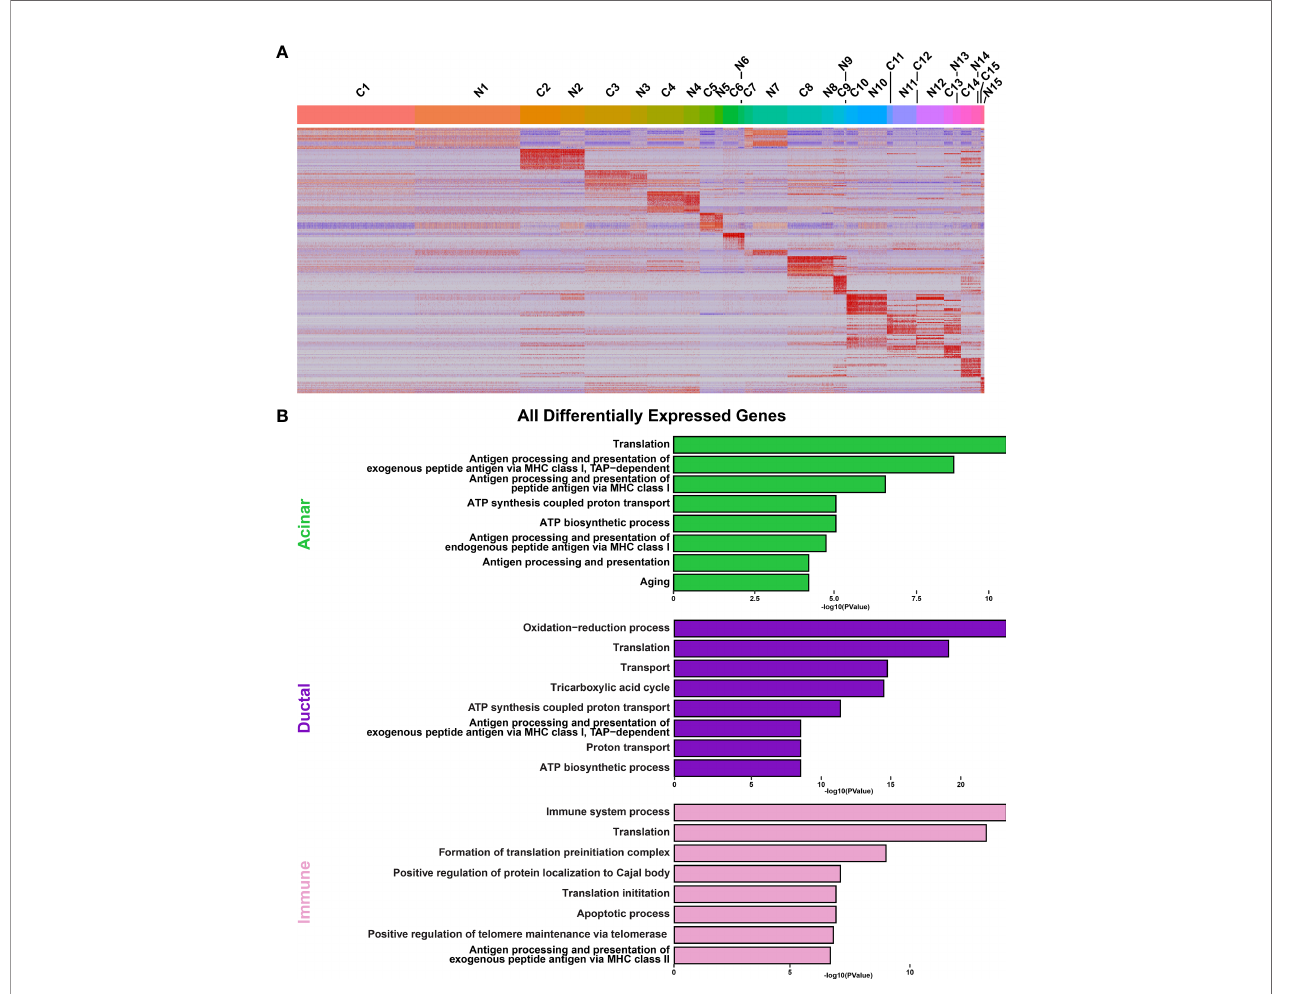
FIGURE 5 | Analysis of Cellular Populations as Identi fi ed by Single-cell RNA-sequencing. (A) Heatmap visualization of the top 20 differentially expressed genes in each cluster as compared with all clusters between control (C) and NOD.B10 (N) SMGs. Upper bars represent cluster assignments. (B) DAVID analysis of all DEGs in the acinar (green), ductal (purple), and immune (pink) cell